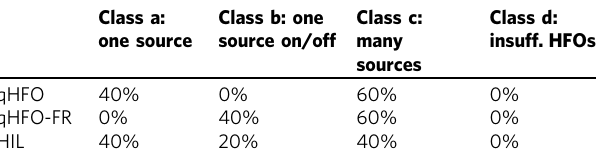
Results are shown for each of the 5 UM patients that had multiple SOZ identi fi ed during monitoring,strati fi edby thethree HFOdetectionmethods.Classes correspondtothose